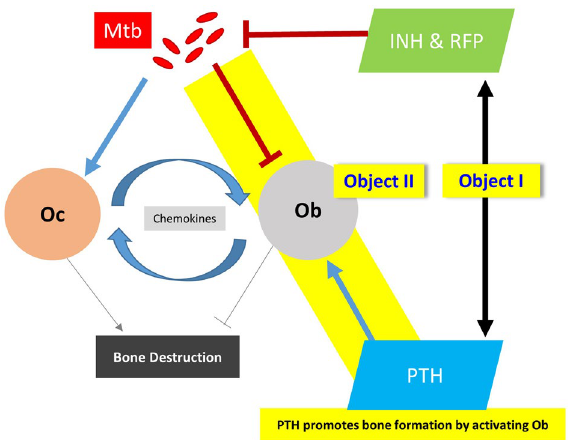
Figure 5. Schematic diagram of experimental design. Study objective was to address two questions to provide essential evidence to support the usefulness of teriparatide in patients with tuberculous spondylitis in clinical practice. Abbreviations: INH, isoniazid; Mtb, Mycobacterium tuberculosis ; Ob, Osteoblast; Oc, Osteoclast; PTH, teriparatide; RFP, rifampin.